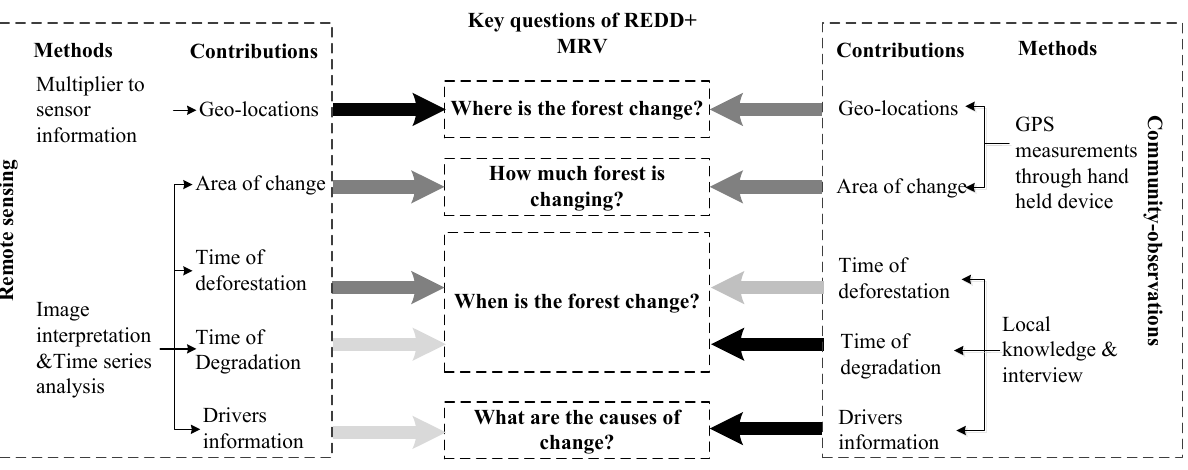
Figure 7. Contributions of remote sensing and community-observation for REDD+ MRV monitoring objectives related to location, size, timing and drivers of forest change; black arrows indicate a very strong contribution; dark grey arrows indicate a reasonably strong contribution; and light grey arrows indicate a limited contribution to these monitoring